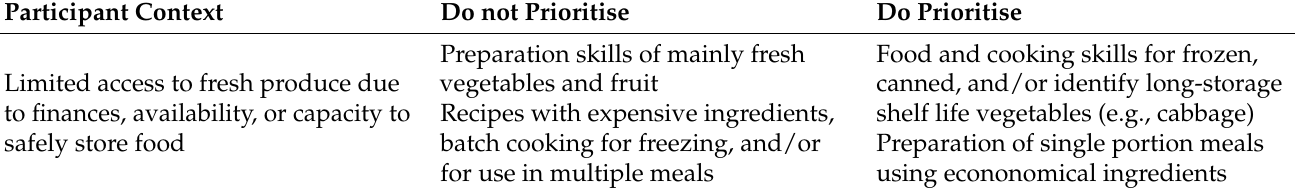
Table 3. Example of prioritising skills in a culinary nutrition education